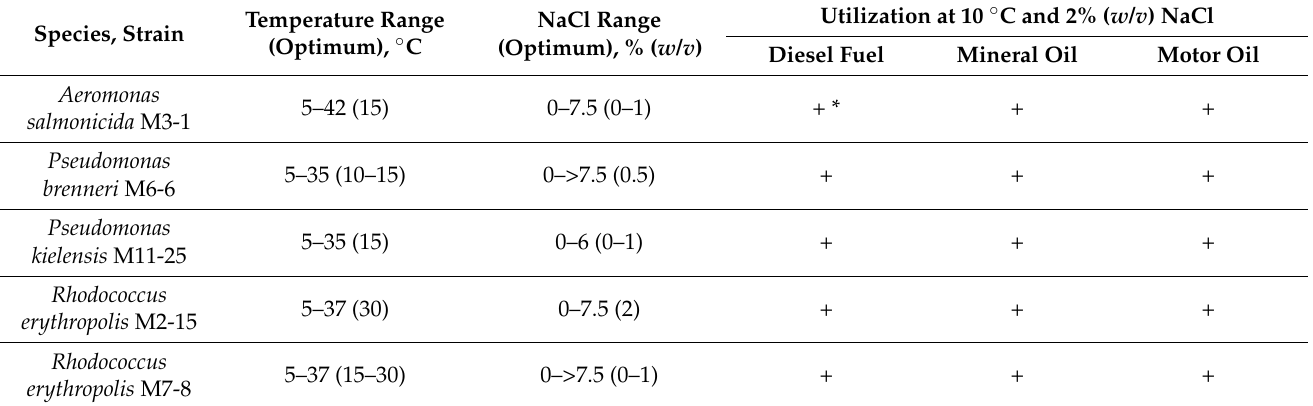
Table 1. Physiological characteristics of isolated hydrocarbon-oxidizing bacteria.